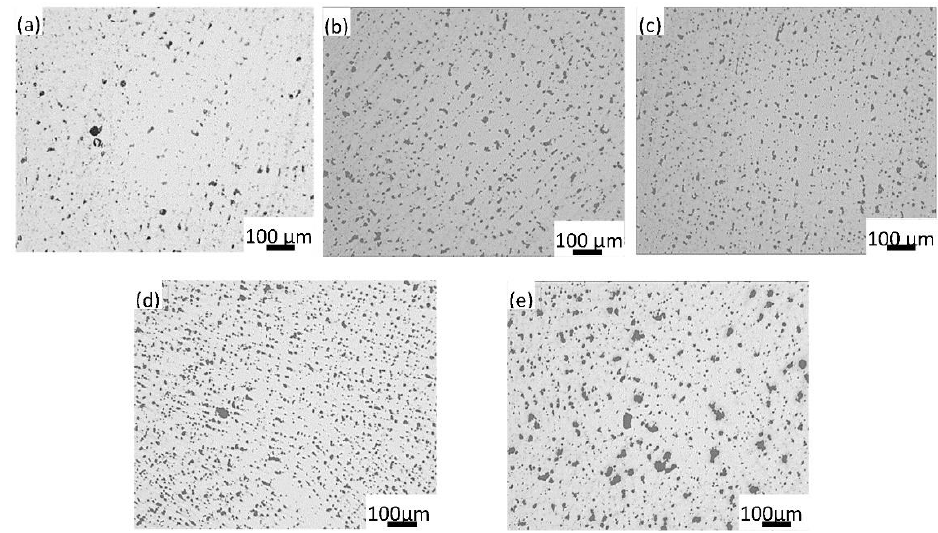
Figure 5. Optical microstructure showing the lead particles of ( a ) ZCuSn10Pb10, ( b ) ZCuSn10Pb10 + 0.05% Y, ( c ) ZCuSn10Pb10 + 0.1% Y, ( d ) ZCuSn10Pb10 + 0.15% Y and ( e ) ZCuSn10Pb10 + 0.2% Y.